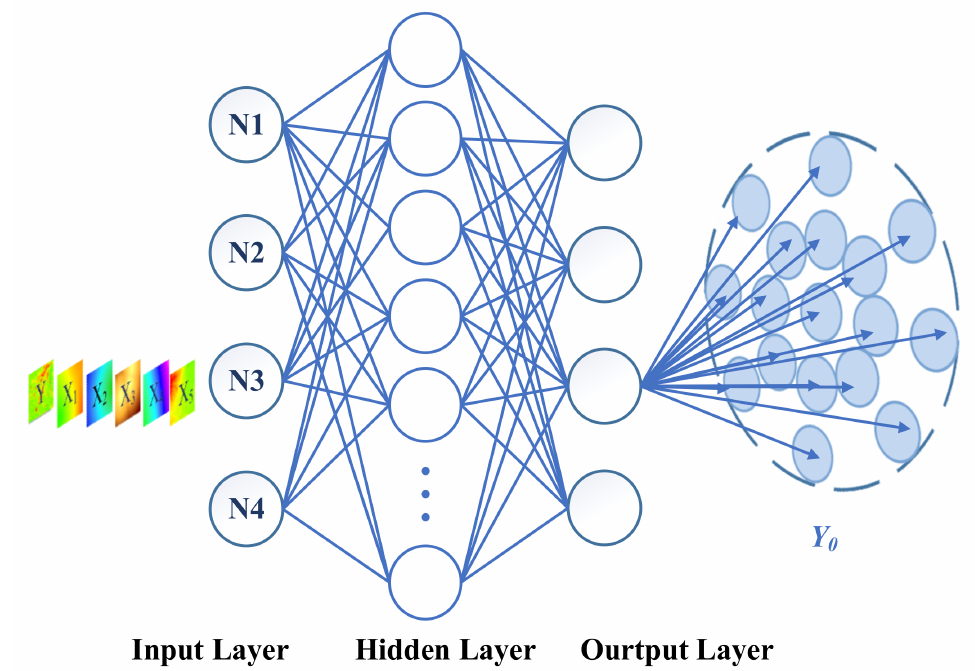
Figure 1. The modeling process of GWANN. N1, N2, N3, and N4 are the multiple input neurons composing the input layer. The rectangles on the left represent the attributes of each input neuron ( y -value and x -values), and Y 0 is the